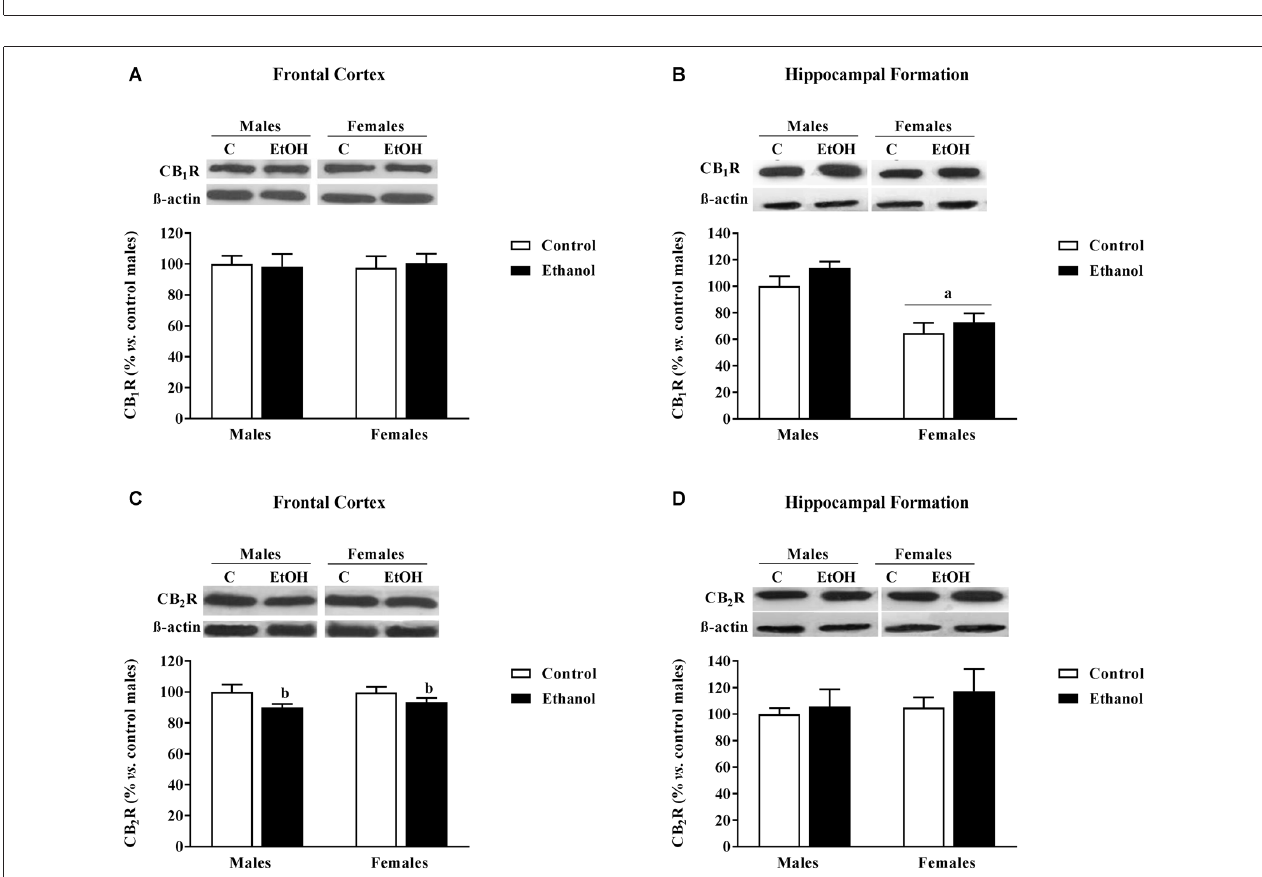
FIGURE 5 | Cannabinoid Receptors (CB1R and CB2R) expression. Protein expression levels within the (A,C) FC and (B,D) HF of adult male and female rats that were exposed to a ethanol (20% in drinking water) or tap water for 2-h sessions during 3 days, and for an additional 4-h session on the 4th day, every week during adolescence, from pnd 28–52. Histograms (mean ± SEM) represent the protein levels expressed as values of optical density calculated as changes from the control male group (%); representative western blotting bands are presented above each histogram. ANOVA, a p < 0.05 general effect of sex; b p < 0.05 general effect of treatment. n = 6 per experimental group, coming from four